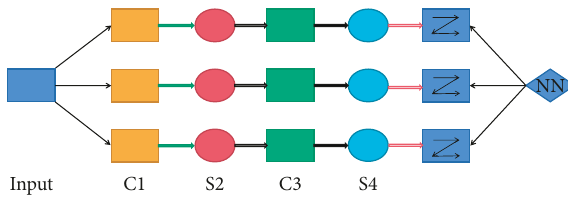
Figure 3: Basic structure of